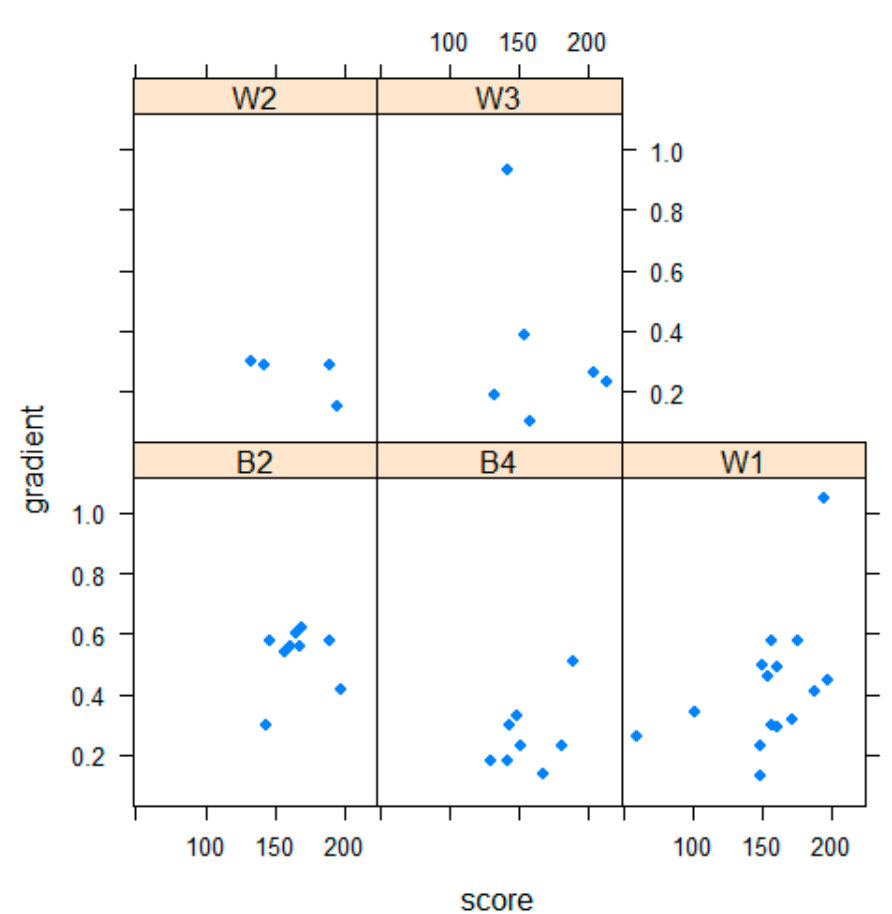
Figure 2. Plots, for individual sheep (identities respectively were W2, W3, B2, B4, W1) of gradient of the grazing-interval trajectory ( x -axis) against mean vegetation score ( y -axis) for each watch; 4 of the 46 points are masked in this diagram.